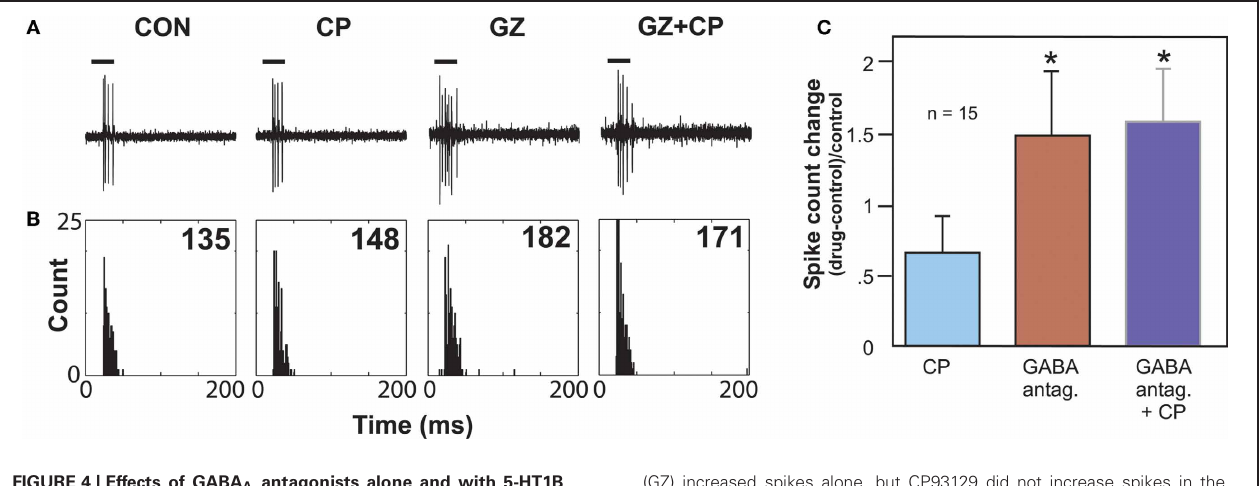
FIGURE 4 | Effects of GABA A antagonists alone and with 5-HT1B agonist CP93129. (A) Single voltage traces in response to a CF pure tone of 11kHz for each drug condition. (B) PSTH plots consisting of 32 trials with a 250ms duration for each trial and corresponding to the voltage traces in (A) . Numbers represent total spike counts for the 32 tone presentations. Both CP93129 (CP) and the GABA A antagonist gabazine